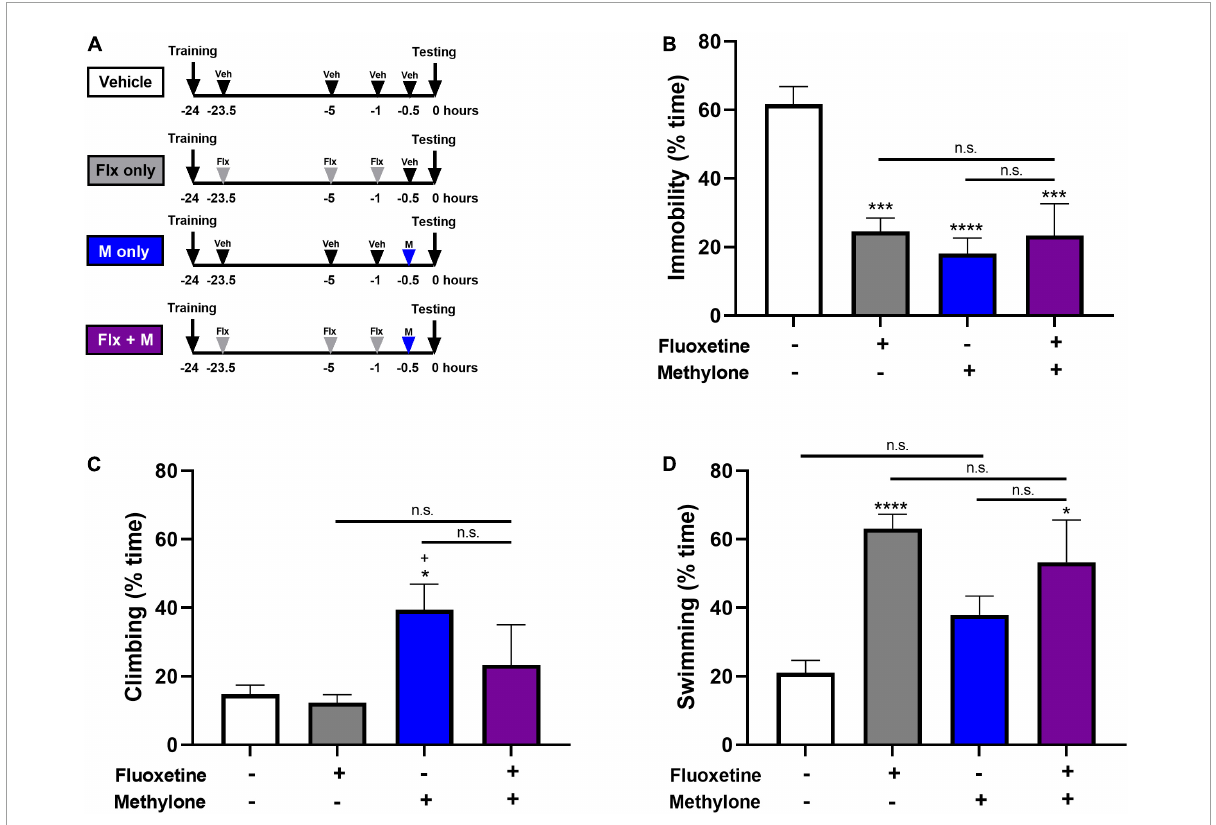
FIGURE6 (A) Schematic shows experimental design and groups tested. Animals received three doses of fluoxetine (10 mg/kg, IP) 23.5, 5, and 1 h before testing and a single low dose of methylone (5 mg/kg, IP) 30 min before testing in the FST. Controls received fluoxetine only, methylone only, or saline vehicle. Quantification of the time spent (B) immobile, (C) climbing or, (D) swimming are shown. Data are presented as means ± SEM. * p < 0.05, *** p < 0.001, **** p < 0.0001 vs. Vehicle control group; + p ≤ 0.05 vs. Fluoxetine alone, n.s., not significant, Bonferroni’s post-hoc test; N = 6–8 animals per